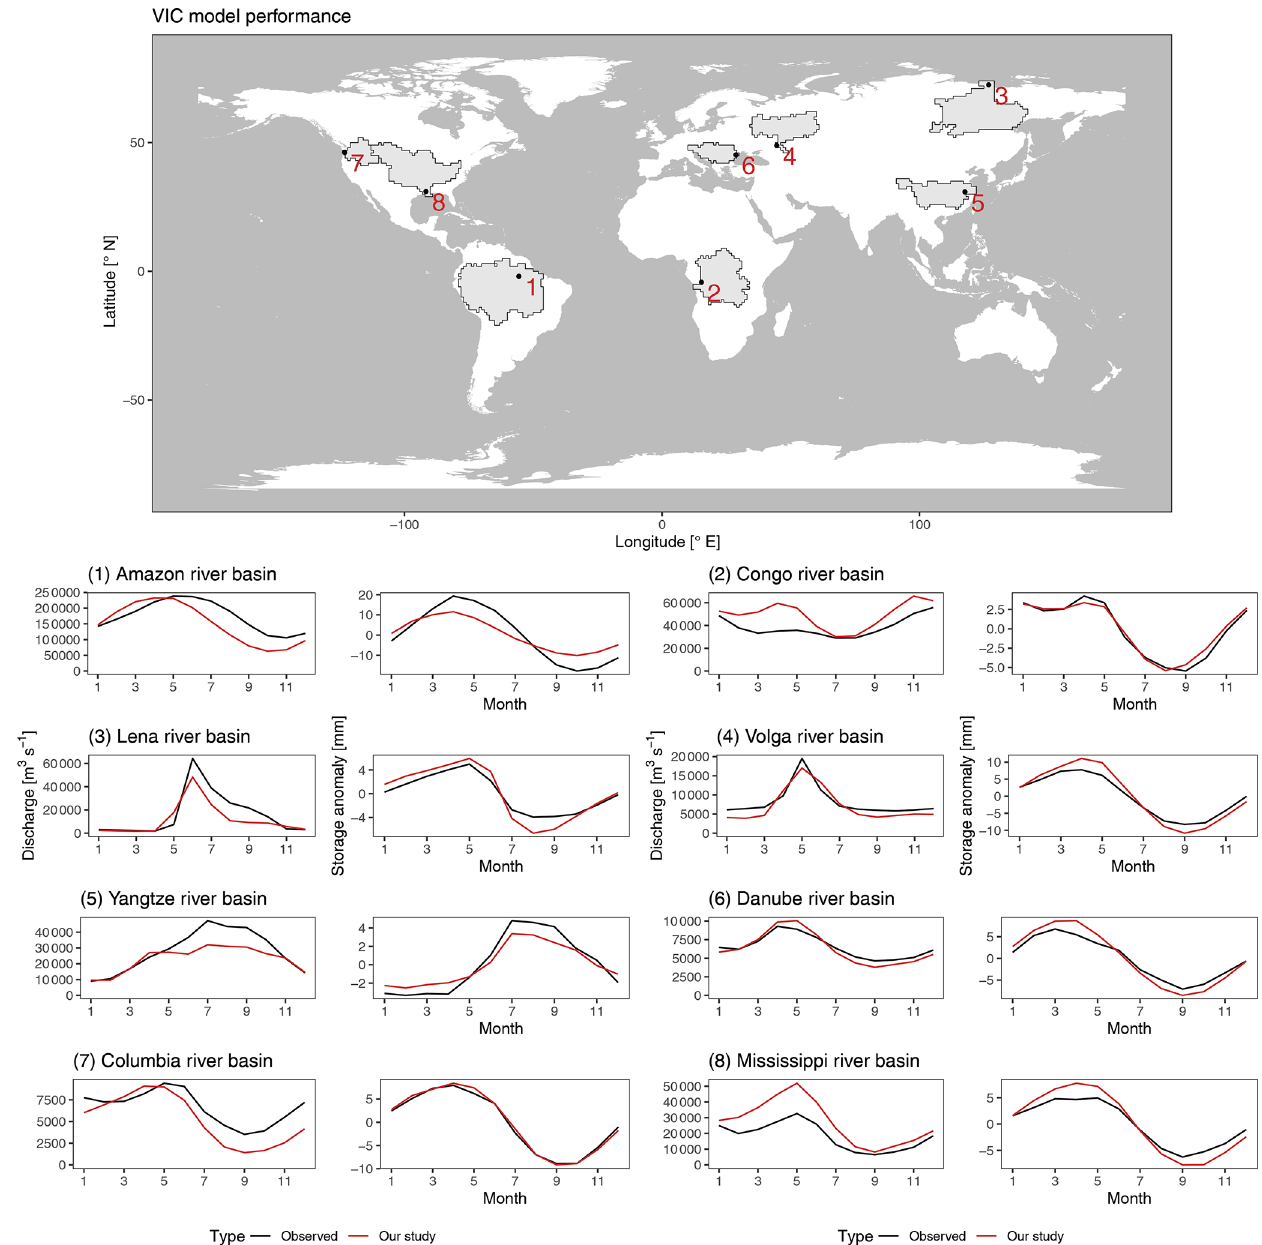
Figure E1. Comparison between simulated discharge and terrestrial total water storage anomalies and GRDC- and GRACE-observed values. Panels indicate the multiyear averages of anthropogenically impacted simulations (red) and observations